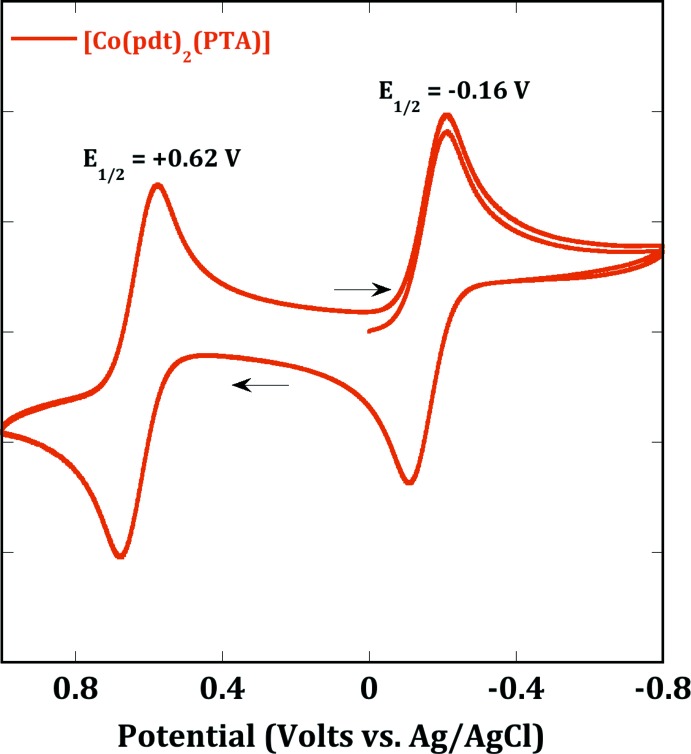
Cyclic voltammetry of [Co(pdt)2(PTA)] in CH2Cl2 recorded using a glassy carbon working electrode and [nBu4N][PF6] as electrolyte with a scan rate of 100 mV s−1 at 25°C.